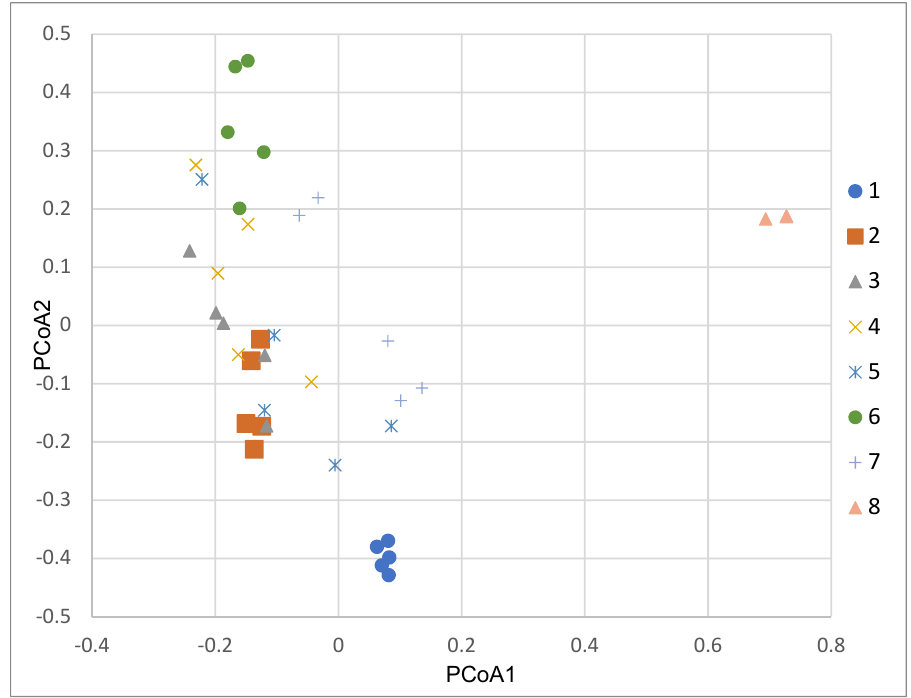
Figure 3. Observed average Simpson's diversity coefficient and linear regression.